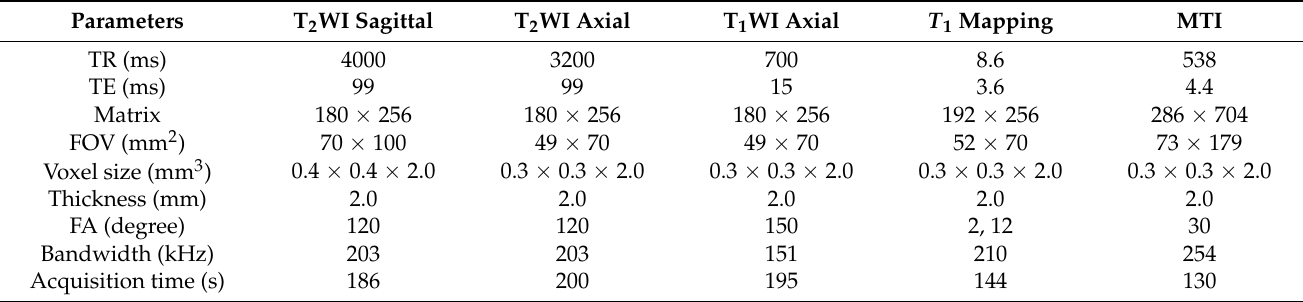
Table 1. MR imaging sequences and